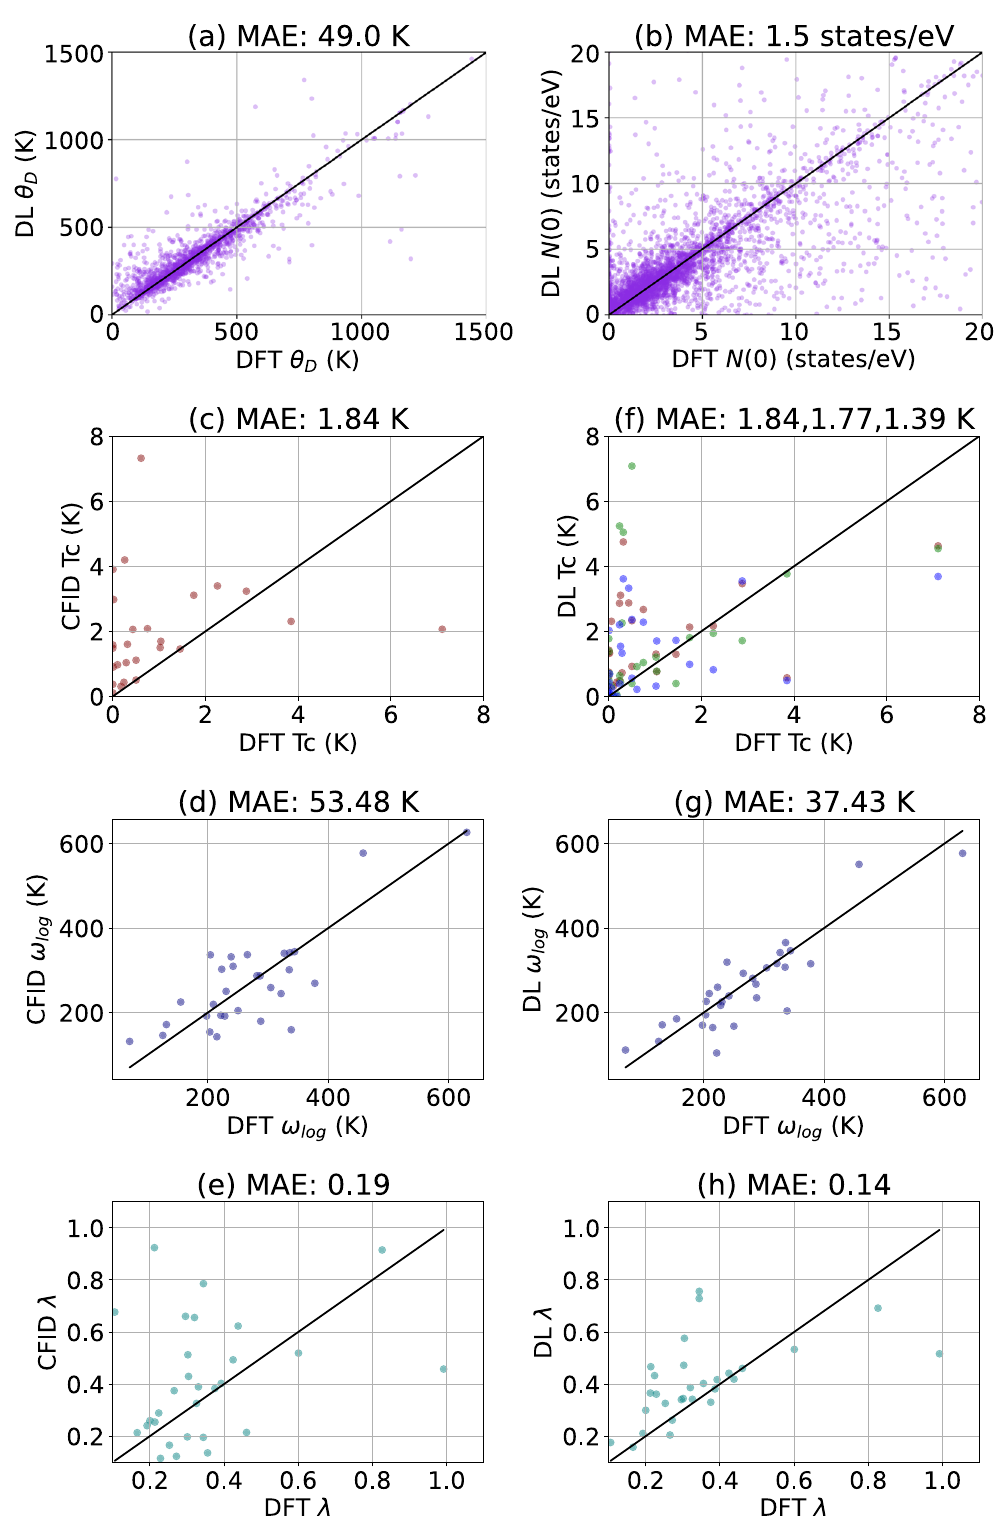
Fig. 6 Machine learning model performance. Atomistic line graph neural network based deep-learning (DL) regression model performance on 5% test set for a Debye temperature and b DOS. Classical force- fi eld descriptor (CFID) ( c , d , e ) and DL ( f , g , h ) based regression model performance on 5% test set for DFT calculated transition temperature ( T C ), EPC parameter ω log , and EPC parameter λ . In f , we show performance with direct T C prediction (red color), T C prediction with direct prediction of wlog and lambda and then using Eq. (7) (green color) and T C prediction with Eliashberg function and then using Eqs. (5 – 8) (black